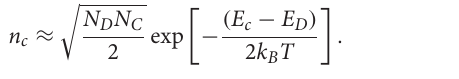
Fermi level existed in the band gap of ZnO along with